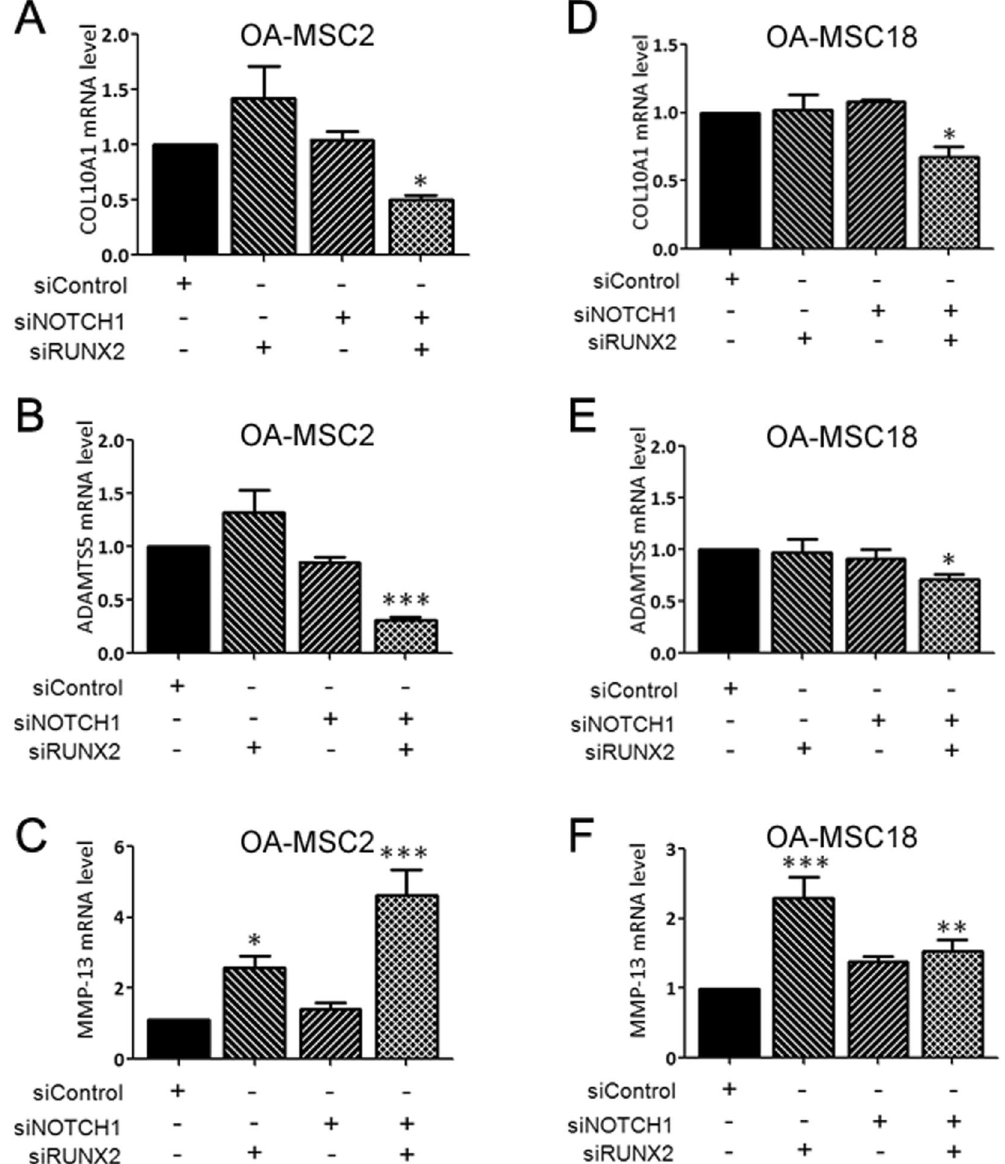
Figure 6. Knockdown of RUNX2 and NOTCH1 are required to attenuate type X collagen expression in clonal OA cartilage-derived MSCs. (A–C) mRNA expression of COL10A1, ADAMTS5 and MMP-13 following transient siRNA-based knockdown of RUNX2 and/or NOTCH1 in OA-MSCL2 and (D–F) in OA-MSCL18 using. n ≥ 3. ** p ≤ 0.05, ** p ≤ 0.01, *** p ≤ 0.005 relative to scrambled siRNA control transfected group. Data are represented as mean ±